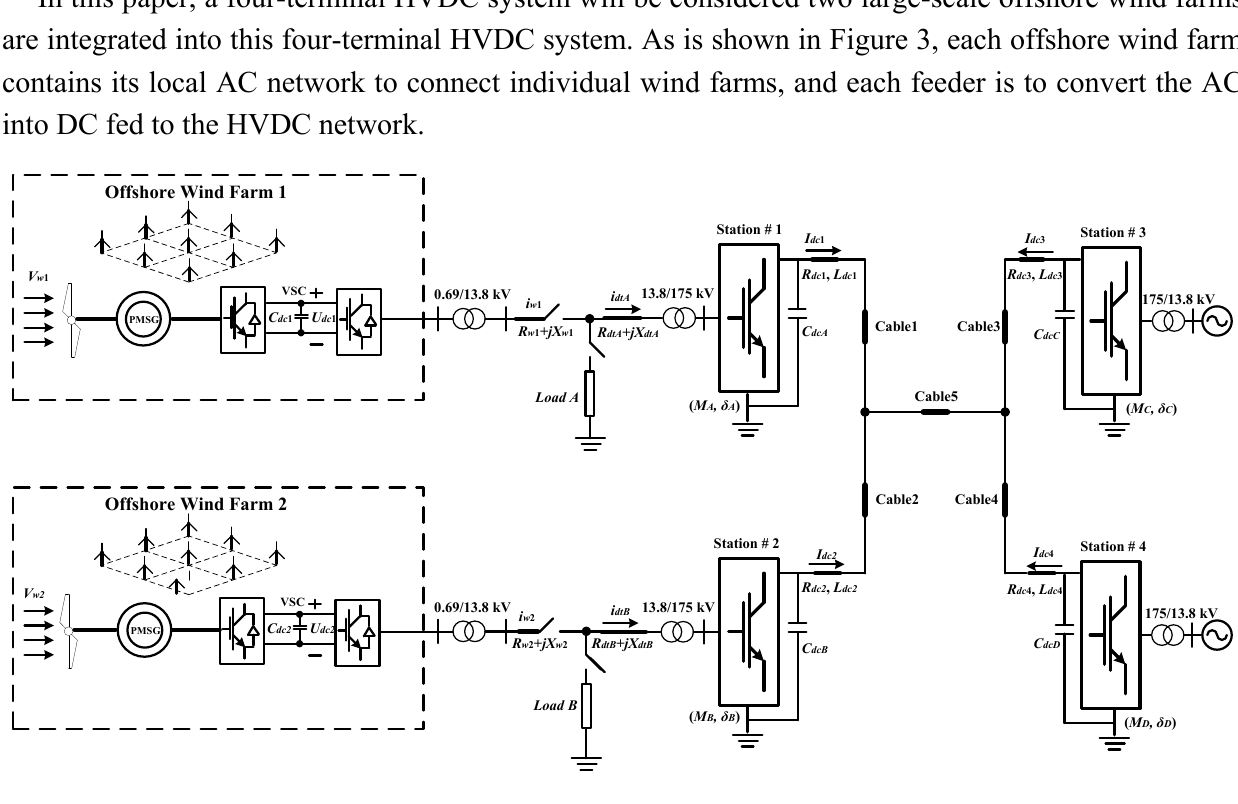
Figure 3. Wind farms integration in a four-terminal HVDC